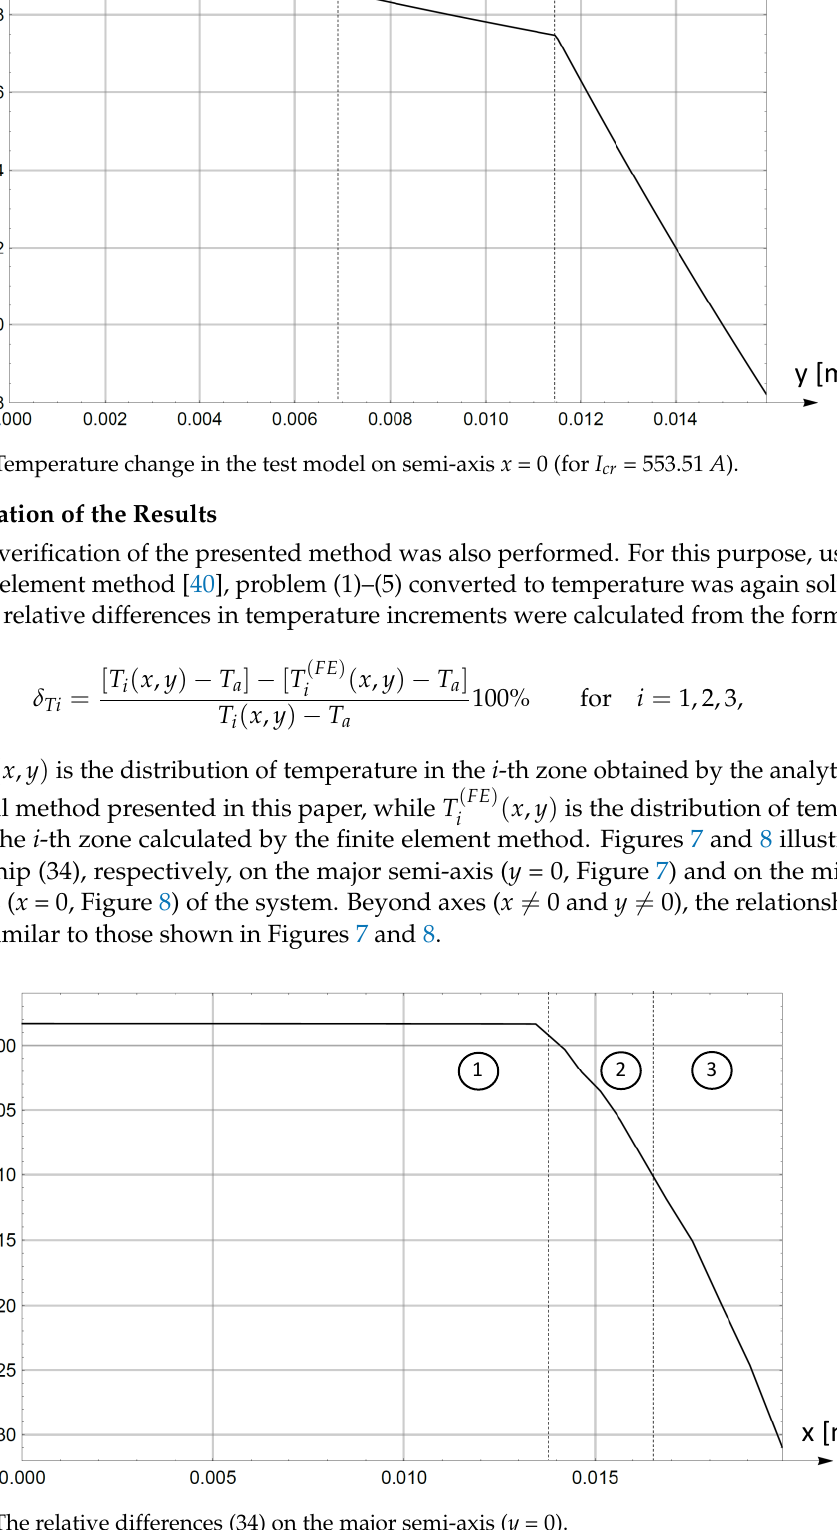
Figure 5. Temperature change in the test model on semi-axis y = 0 (for I cr = 553.51 A ).